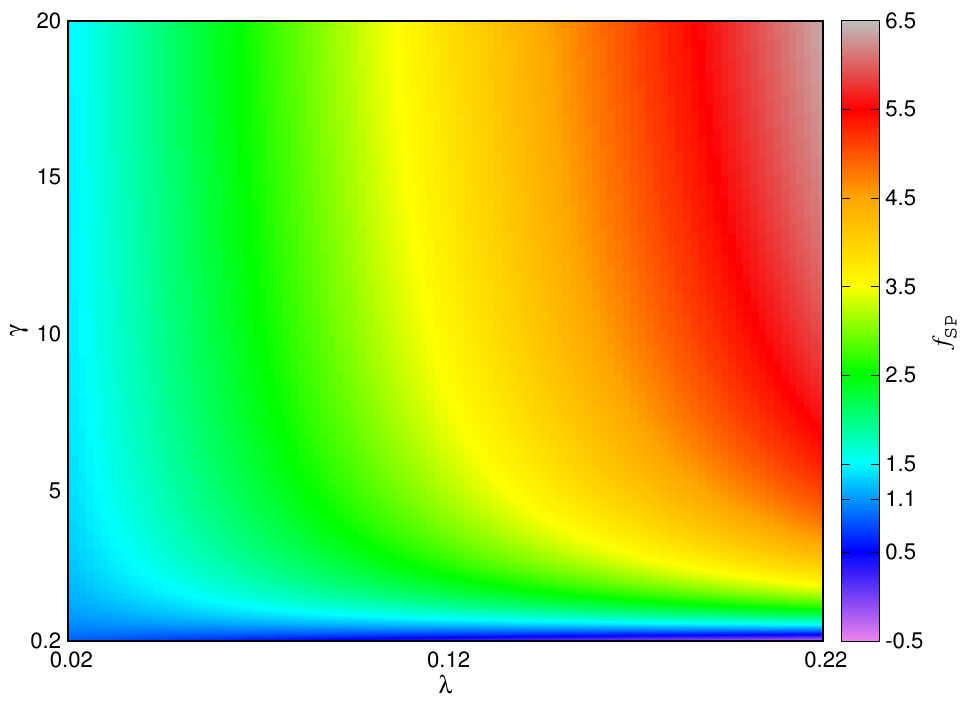
Figure 6. Precessing of the S2 star around RGISBHs f SP in the weak gravitational field with 0.02 ≤ λ ≤ 0.22 and 0.2 ≤ γ ≤ 20.